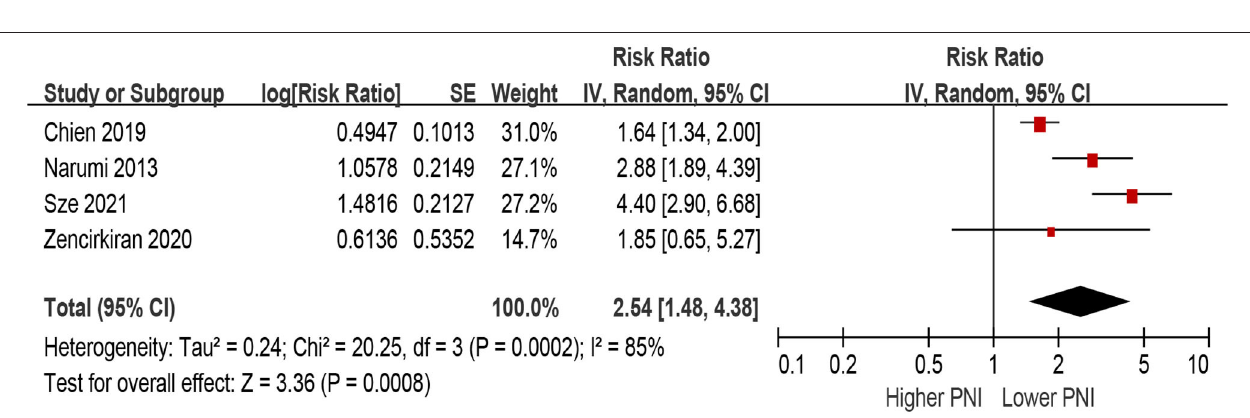
FIGURE 6 | The association between PNI (defined as lower vs. higher) and the risk of major adverse cardiac outcomes (MACEs) in HF (unadjusted model). CI, confidence interval; HF, heart failure; MACEs, major adverse cardiac outcomes; PNI, prognostic nutritional index.